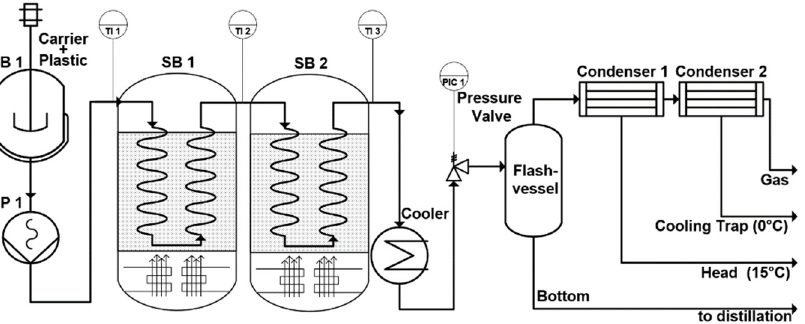
Figure 1. Scheme of the pilot plant.